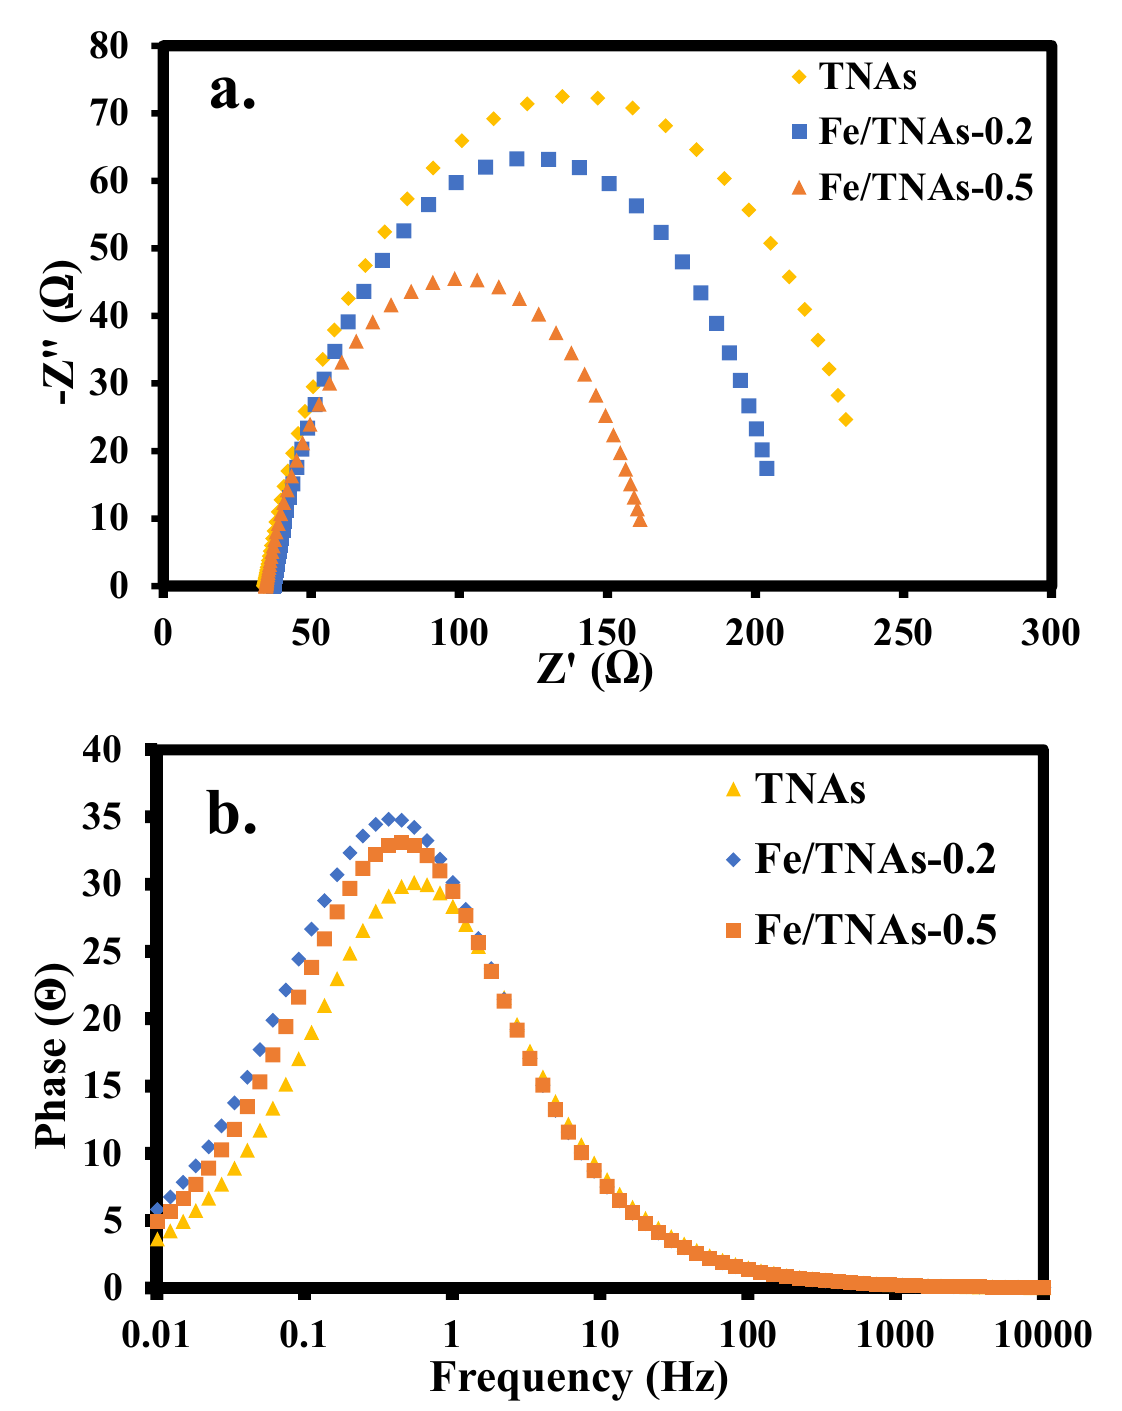
Figure 6. Nyquist plot ( a ) and Bode plot ( b ) based on EIS analyses of TNA, Fe/TNAs-0.2, and Fe/TNAs-0.5. Table 3. Fitting results of equivalent circuits of TNAs and Fe/TNAs.